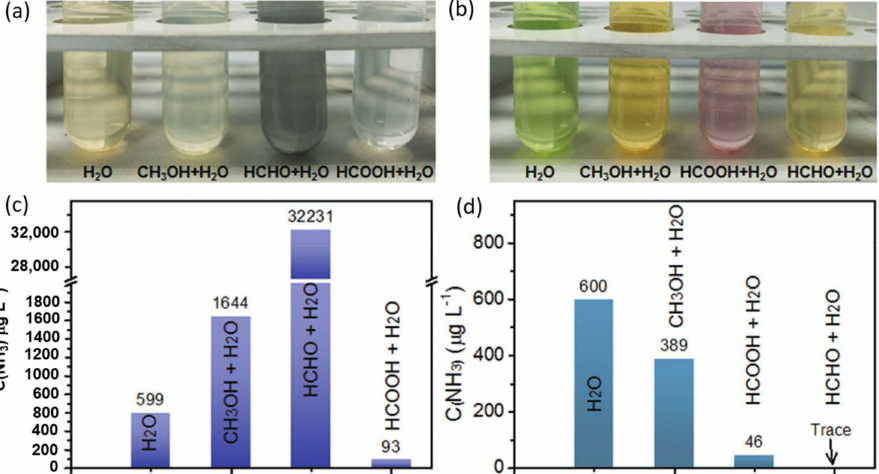
Figure 9. Photograph of the various ammonia solutions in the presence of 40% volume of methanol as the sacrificial reagent and its derived oxidation products determined by ( a , c ) Nessler’s method and ( b , d ) indophenol blue method. The ammonia concentration was 600 µ g L − 1 in all experiments. Adapted with permission from Ref. [35] Wiley-VCH